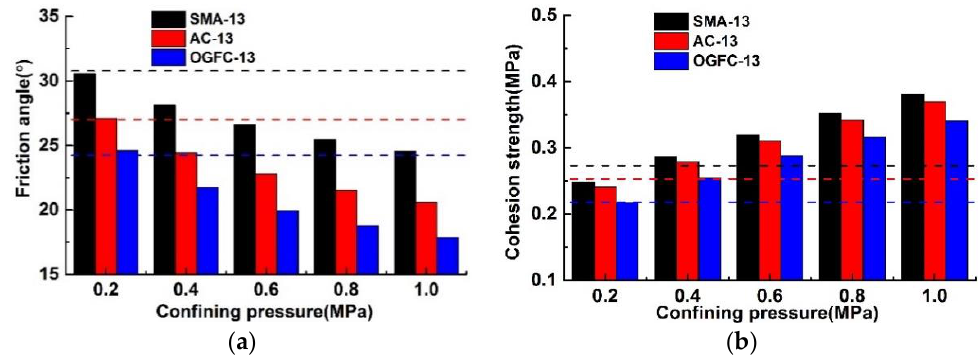
Figure 14. Friction angle and cohesion strength of asphalt mixtures with linear and nonlinear Mohr – Coulomb failure criterions at 60 °C. ( a ) The friction angle of asphalt mixtures with linear and nonlinear Mohr – Coulomb failure criterions at 60 °C; ( b ) The cohesion strength of asphalt mixtures with linear and nonlinear Mohr – Coulomb failure criterions at 60 °C.